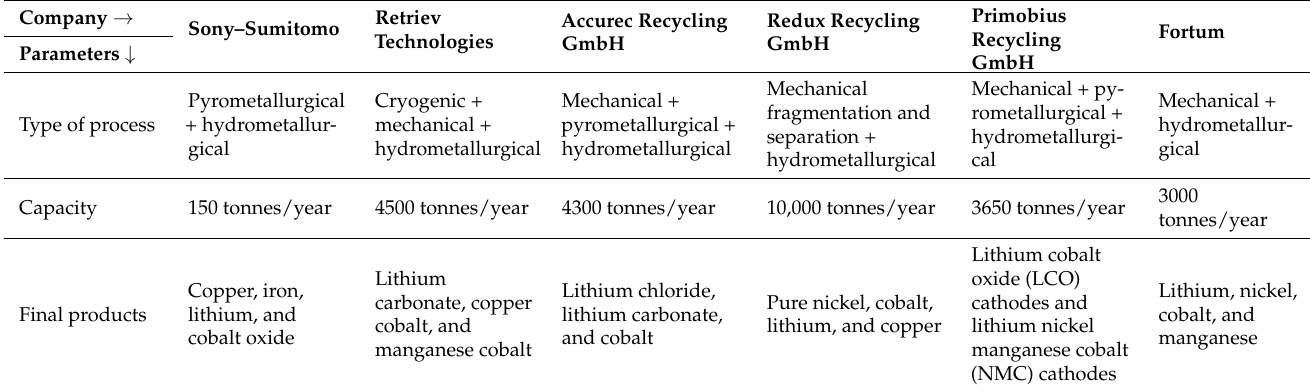
Table 4. Comparison of the processes of the different